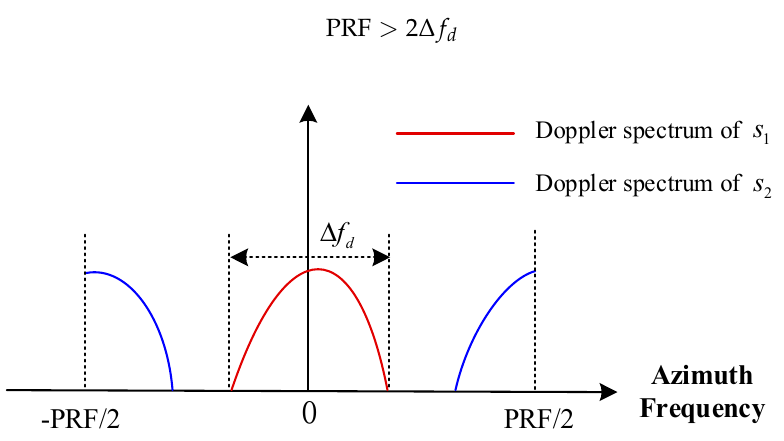
Figure 3. Doppler frequency spectrum of the received signal.